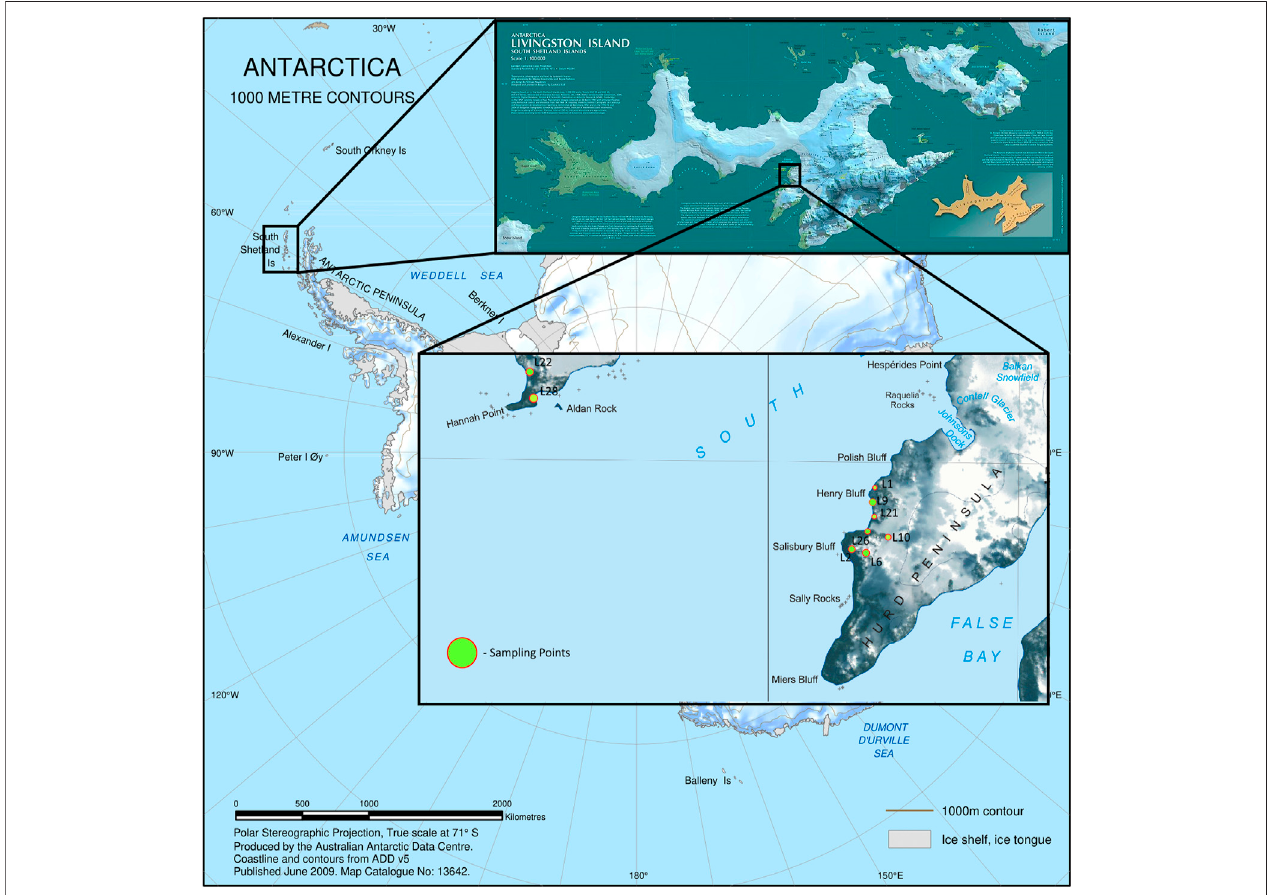
FIGURE 1 | Location map of St. Kliment Ohridski station (AAD, 2009; Ivanov, 2015).